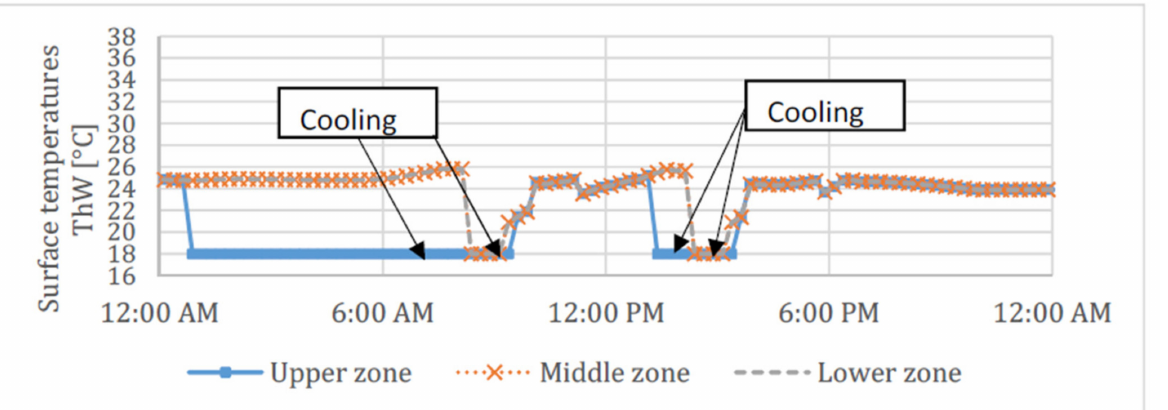
Figure 11. Controlled surface temperatures of the thermoelectric partition based on the local and overall sensation values of specific body parts (head, left arm, and pelvis)—one-day simulation in